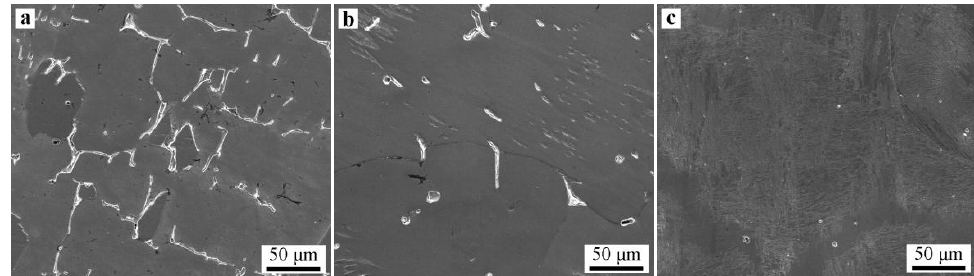
interdendritic segregation in the ESR ingot. Blue line in ( a ) is the range of line scan.